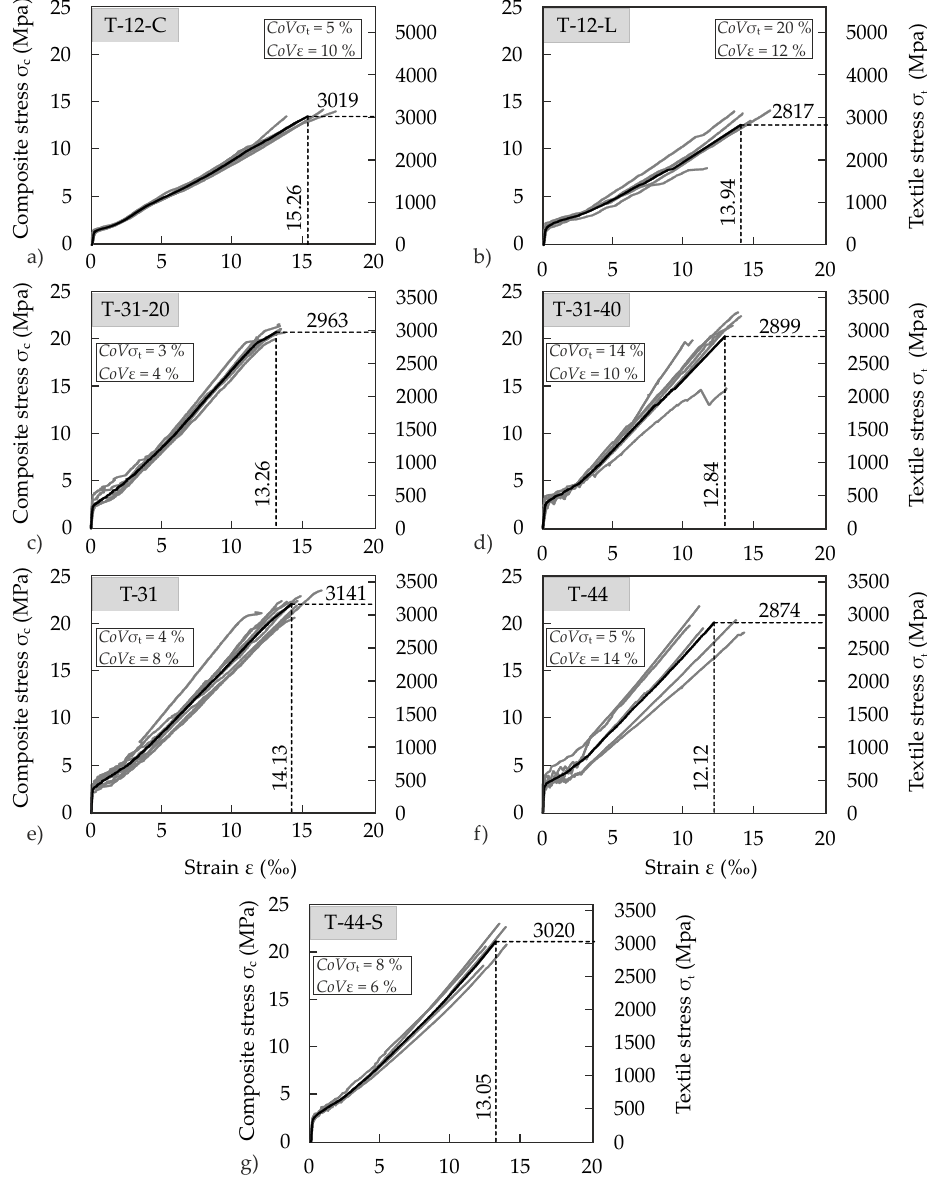
Figure 7. Stress–strain relations of seven exemplary groups of uniaxial tensile tests on composite strips with seven di ff erent material combinations ( a – g ) and indication of the scatter of ultimate stresses, σ , and strains, ε , by means of the coe ffi cient of variation